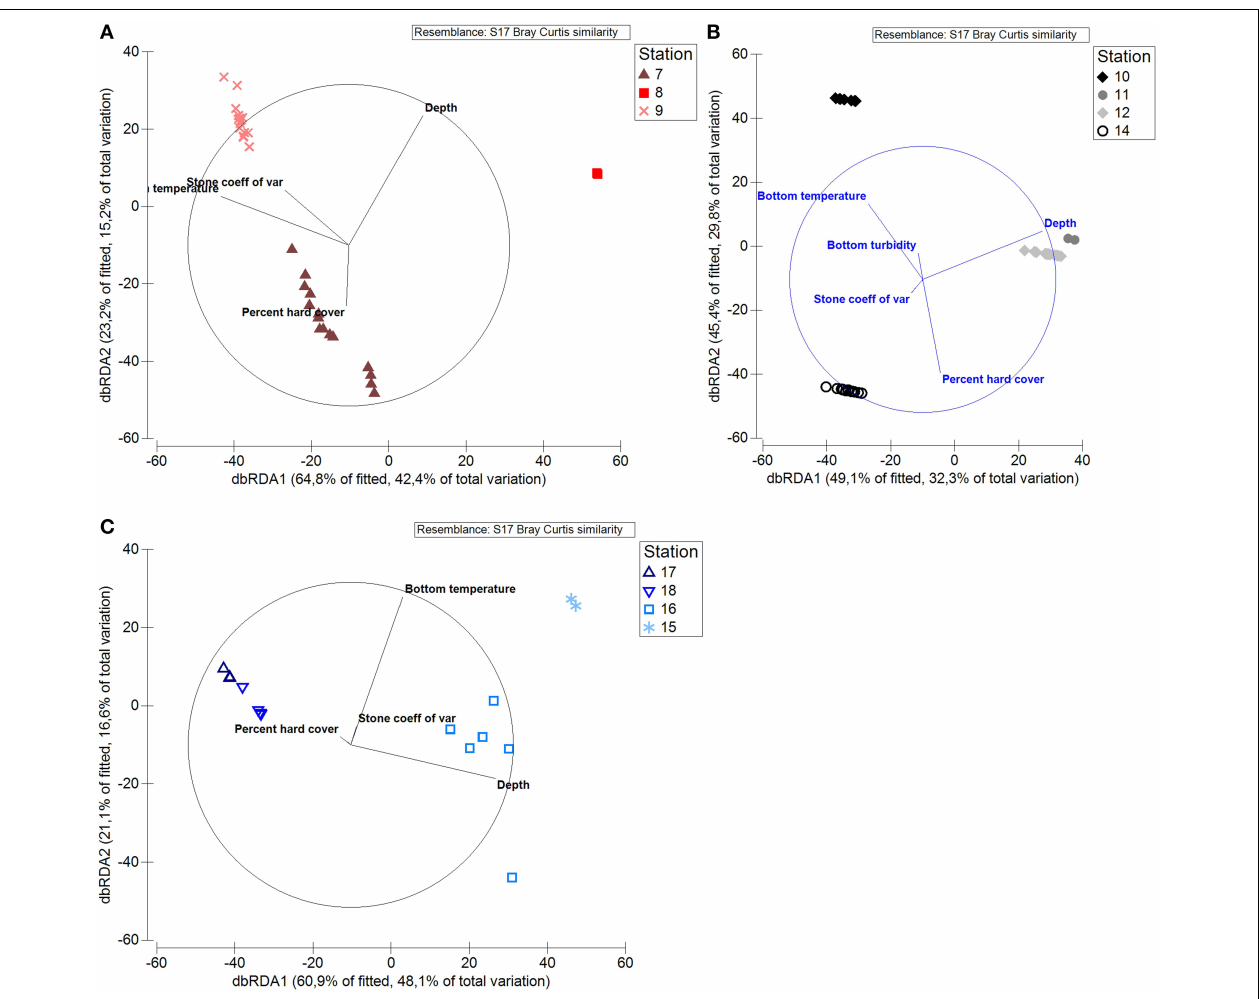
FIGURE 11 | dbRDA graph showing relationship of north Svalbard fauna to abiotic factors on local scale.(A) Stations in Raudfjorden, (B) stations on north Svalbard shelf, (C) stations in